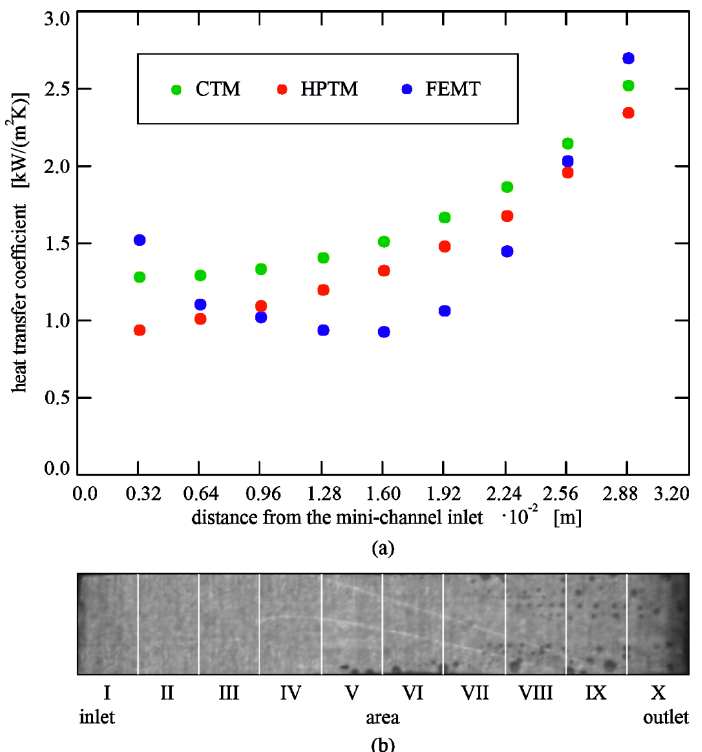
Figure 9. ( a ) Heat transfer coefficient versus distance from the mini-channel inlet, ( b ) two-phase flow pattern, t = 460 s; other experimental parameters are listed in Table 1. When analyzing the heat transfer coefficient dependence versus distance from the mini-channel inlet, achieved for three time moments: 380 s, 420 s, and 460 s (Figures 7a, 8a and 9a), an increase in coefficient values with the distance is noticed. In these cases, a certain amount of vapor bubbles increasing with time (and supplied heat flux) is ob- served near the channel outlet (Figures 7b, 8b and 9b), resulting in higher void fraction (up to 8.54%). The local heat transfer coefficients obtained for the first selected moment of time, i.e., 340 s (Figure 6a), are the lowest in comparison with other results. It should be underlined that, although the temperature data indicate the occurrence of subcooled flow boiling, one can hardly see any bubbles (Figure 6b), and the maximum void fraction does not exceed 0.58%. The curves based on the CTM and the HPTM computations show the same trends, whereas the FEMT curves slightly differ from them, indicating a higher sensitivity to the experimental data including void fraction: reaching minimum in the middle of the channel, and the maximum of the coefficient values at the channel inlet and outlet. Furthermore, all plots of heat transfer coefficient appeared to be similar, which confirms the acceptable range of variation of the coefficient.